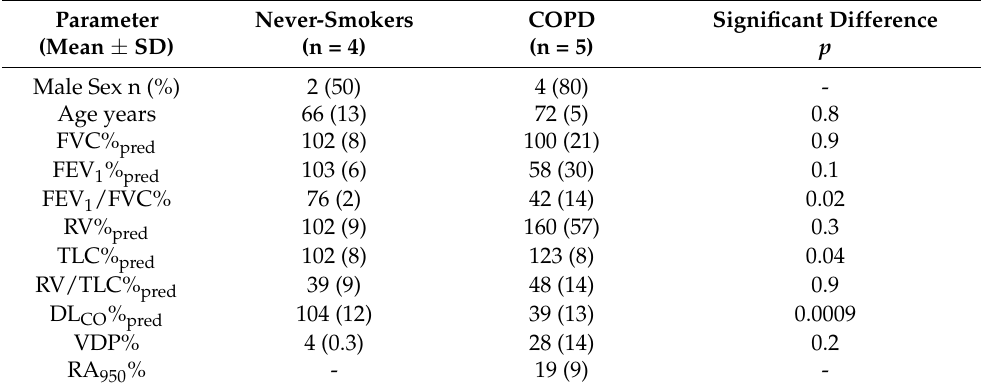
Table 1. Participant demographic and imaging measurements.